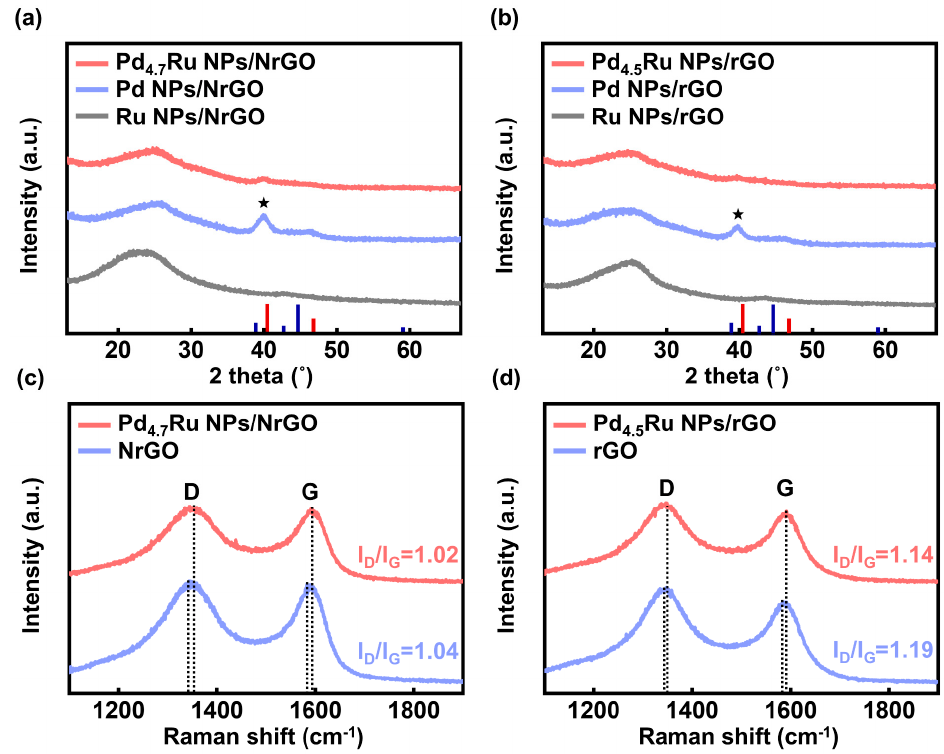
Figure 3. XRD patterns of ( a ) Pd 4.7 Ru NPs/NrGO, Pd NPs/NrGO, Ru NPs/NrGO and ( b ) Pd 4.5 Ru NPs/rGO, Pd NPs/rGO, Ru NPs/rGO. Red and blue bars indicate the peaks in the standard patterns of Pd (ICDD 00-001-1201) and Ru (ICDD 00-001-1253), respectively, and the stars correspond to Pd (111). Raman spectra of ( c ) Pd 4.7 Ru NPs/NrGO, NrGO and ( d ) Pd 4.5 Ru NPs/rGO, rGO, and the dotted line represents the Raman shift of D and G bands for each sample.